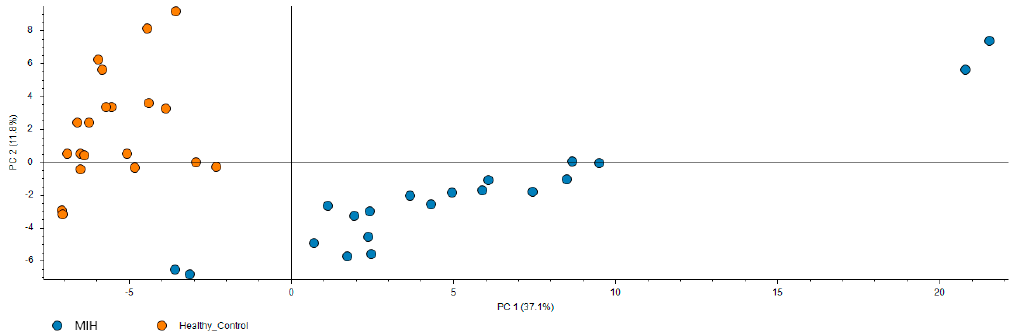
Figure 1. PCA clustering of the MIH (blue dots) and the healthy control (orange dots) reveal a clear discrimination of the two groups.